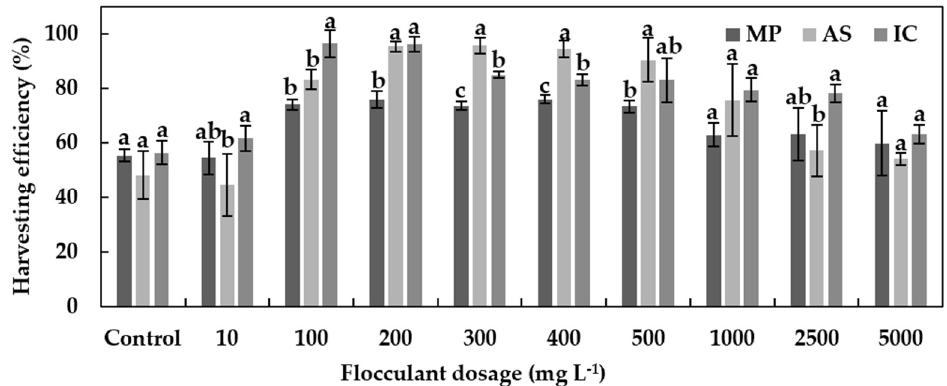
Figure 1. Effect of nine dosages of Moringa oleifera seed powder (MP), aluminium sulfate (AS), and iron (III) chloride (IC) on the harvesting efficiency of a mixed culture of Desmodesmus sp. and C. vulgaris (500 mg L − 1 ) after a 60-min sedimentation time. Control without the addition of flocculants was also carried out in the same conditions as the assays with the addition of flocculants. The rotation speed and time used were 150 rpm for 5 min, followed by 70 rpm for 20 min in an orbital shaker. Columns represent the average values, and error bars represent the standard deviations of triplicates. Different letters indicate significant differences between the flocculants for a same dosage after a one-way ANOVA followed by a Tukey test ( p < 0.05).